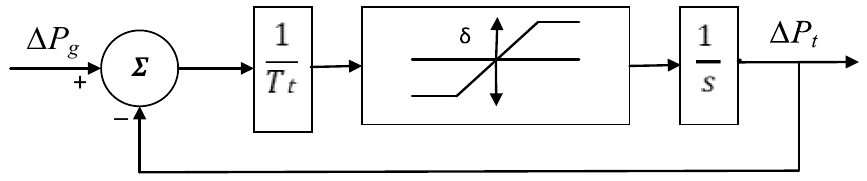
Figure 14. Non-linear turbine model with GRC.